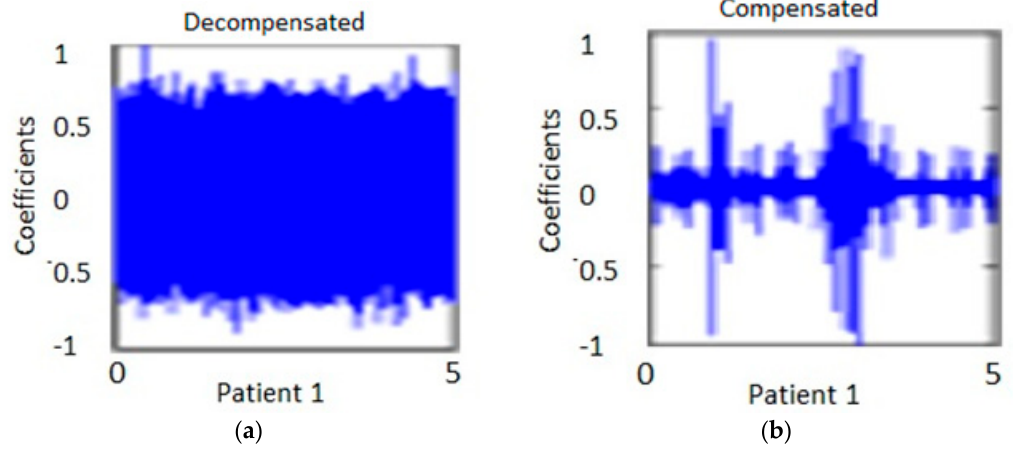
Figure 7. ( a ) Diagonal details (coefficients) of heart signals measured at location E for one of the patient, with decompensated state, as analyzed using the wavelet transform. ( b ) Diagonal details (coefficients) of heart signals measured at location E for the same patient as in ( a ), with measurement taken at compensated state, as analyzed using the wavelet transform.